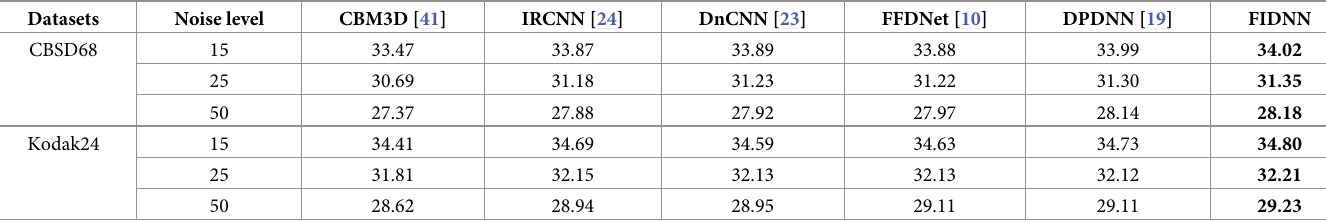
Table 4. Average PSNR results of denoising by different methods on CBSD68 and Kodak24 datasets. Datasets